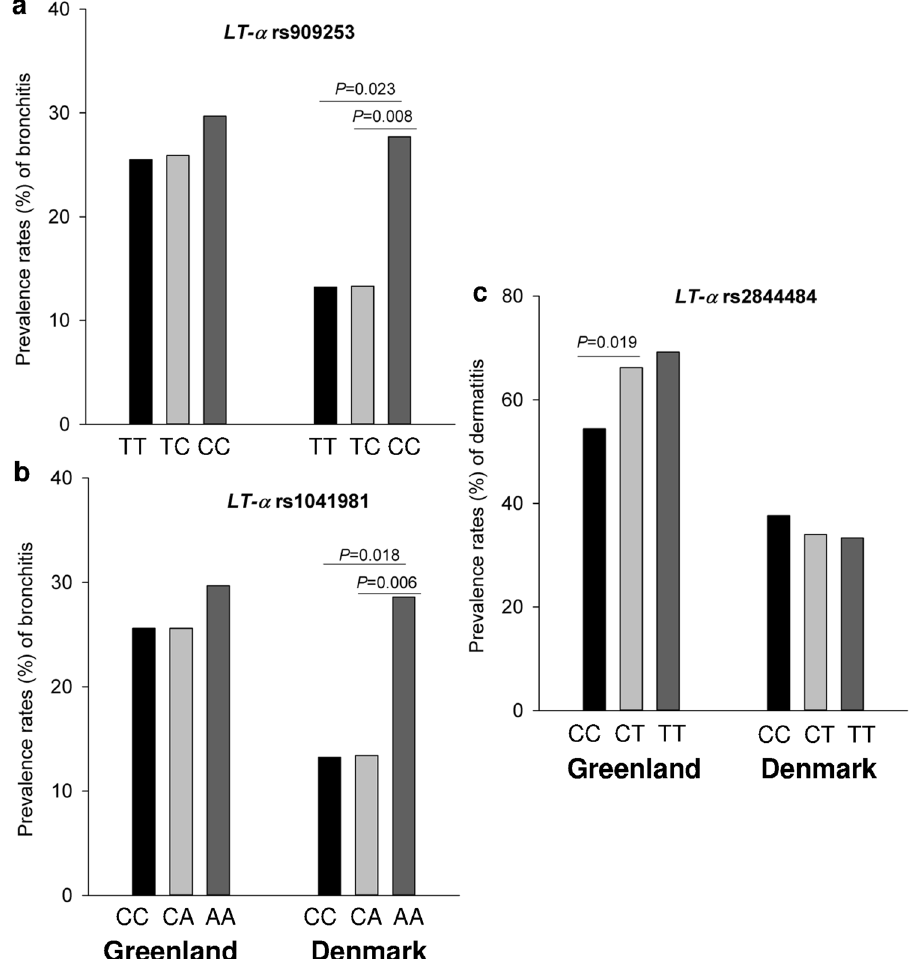
Figure 3. Prevalence of bronchitis/dermatitis and genotypes in the sensitivity analysis: Prevalence rates (%) of bronchitis in Greenlandic and Danish Inuit with full ethnicity were stratified by the genotypes of LT- α SNP rs909253 ( a ) and rs1041981 ( b ), while dermatitis prevalence was stratified by the genotypes of LT- α SNP rs2844484 ( c ). P values were adjusted for age, gender, height, and